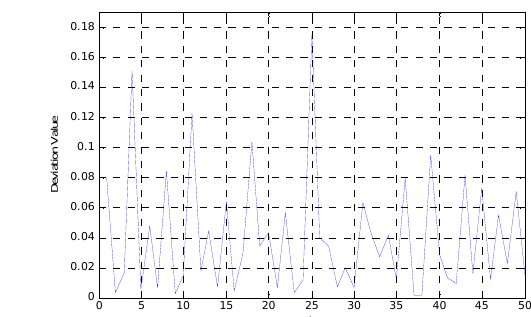
Fig. 17. The prediction value and the deviation value for Mackey-Glass time series.